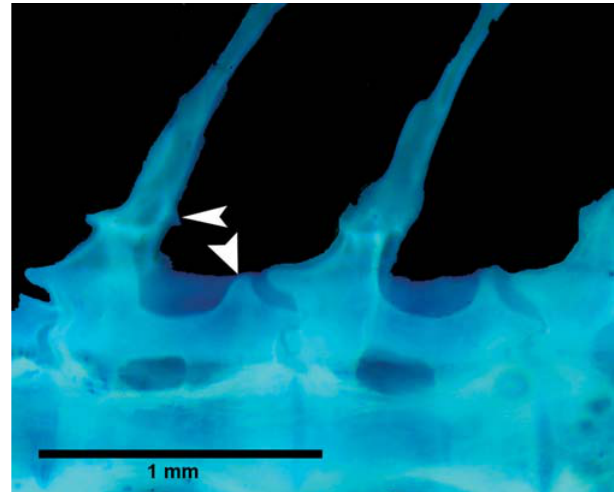
Fig. 5. Detail of the dorsal region of precaudal vertebrae of Aspidoras psammatides , paratype, MNRJ 21709, 22.6 mm SL, showing their post-zygapophyses not connected with respec- tive neural spine (arrows). fuse brown blotch on middle region of cleithrum. Minute dark brown dots scattered over entire surface of trunk; more concentrated on dorsal region. Dots clustered around bases of dorsal spine, last dorsal-fin ray and adipose-fin spine, re- spectively. Small diffuse brown blotches along lateral junc- tion of body plates, from cleithrum to caudal peduncle. Blotches varying in number from five to (more commonly) eight blotches. Ventral surfaces of body yellowish white.